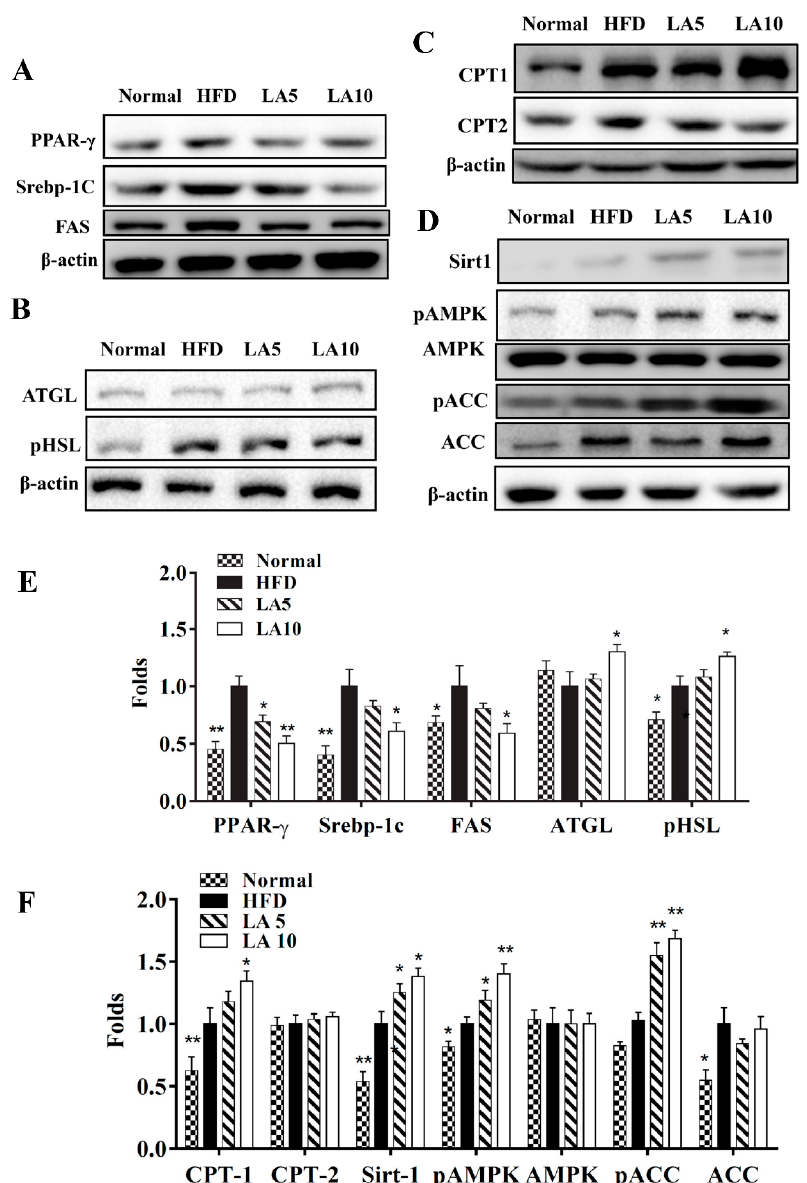
Figure 4. Effects of licochalcone A (LA) on lipid metabolism in mouse liver tissue. ( A ) Expression of transcription factors associated with adipogenesis and lipogenesis, ( B ) lipolysis, ( C ) β -oxidation, and ( D ) the sirt-1/AMPK pathway were detected by Western blot. ( E , F ) The fold expression levels were measured relative to the expression of β -actin. Three independent experiments were analyzed using β -actin as an internal control. The data are presented as the mean ± SEM. * p < 0.05, ** p < 0.01 compared to the HFD group.